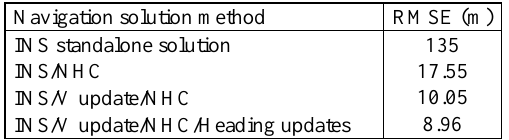
Table 1. The average position RMSE for the first data set for